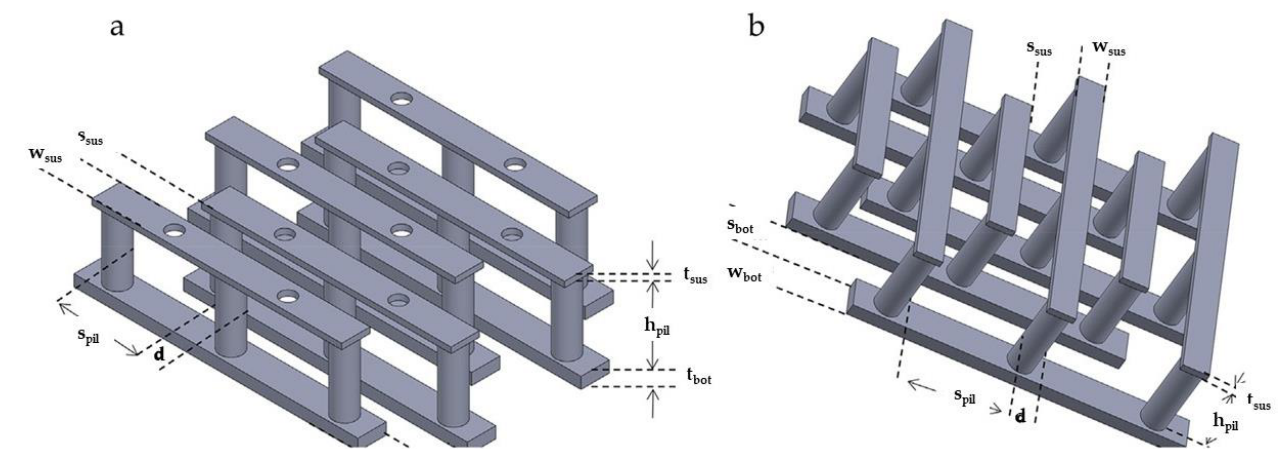
Figure 6. Suspended layer with: ( a) stripes connecting pillars of the same finger (3D//); and ( b ) stripes connecting different fingers of the same electrode (3D # ). Reproduced from [145]. Copyright © 2022, Elsevier under the terms of the Creative Common CC-BY license.